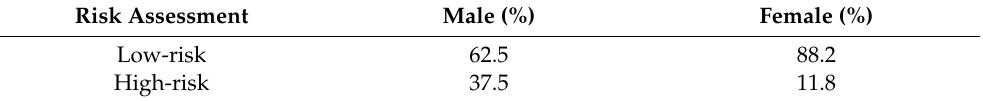
Table 1. The risk profile of the survey’s participants divided into male and female in